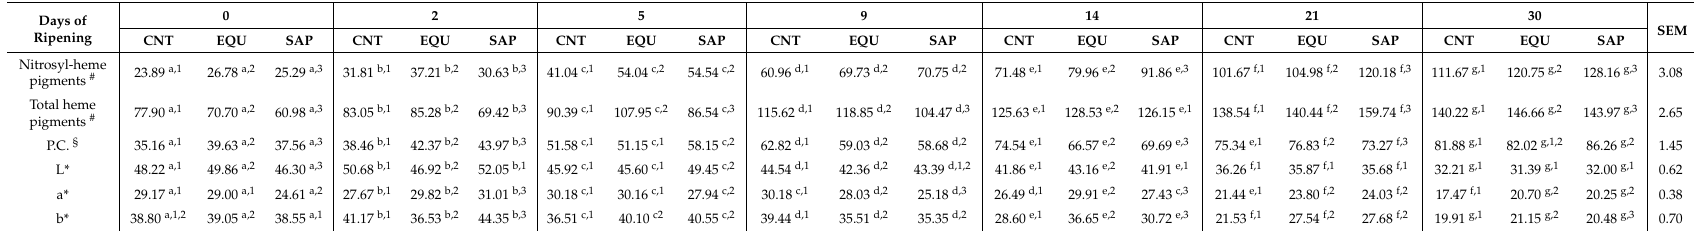
Table 2. Evolution of the colour parameters along the manufacturing process of Galician chorizo made without and with starter cultures (means of three replicates in each sausage